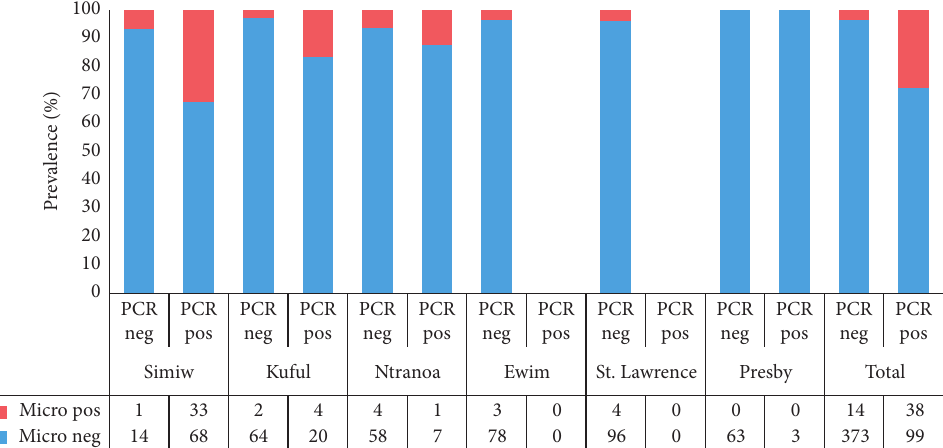
Figure 4: Site-specific sensitivity and specificity of microscopy. A bar graph representing the specificity and sensitivity of the P. falciparum - specific microscopy results relative to P. falciparum -specific PCR. PCR neg, sample tested negative for P. falciparum by PCR; PCR pos, sample tested positive for P. falciparum by PCR; micro neg, sample that did not contain P. falciparum by microscopy; micro pos, sample that tested positive for P. falciparum by microscopy. The data in the table represent exact